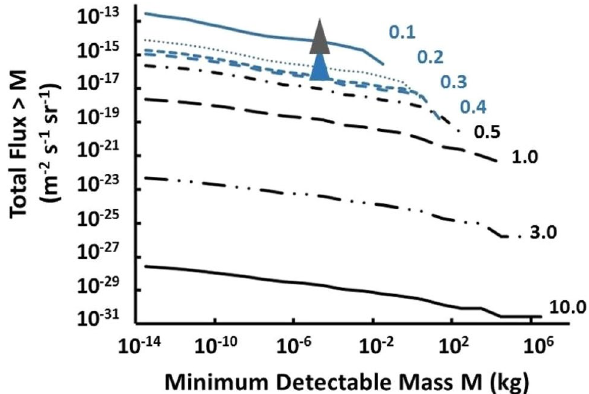
Figure 5. Plot of total MQN flux for mass greater than M as a function of B o . The bottom of the grey triangle shows the flux limit for exclusion by the data from the GSL experiment with 90% CL. The bottom of the blue triangle indicates exclusion by the telescope data from Piotrowski, et al . and Porter, et al . applied to